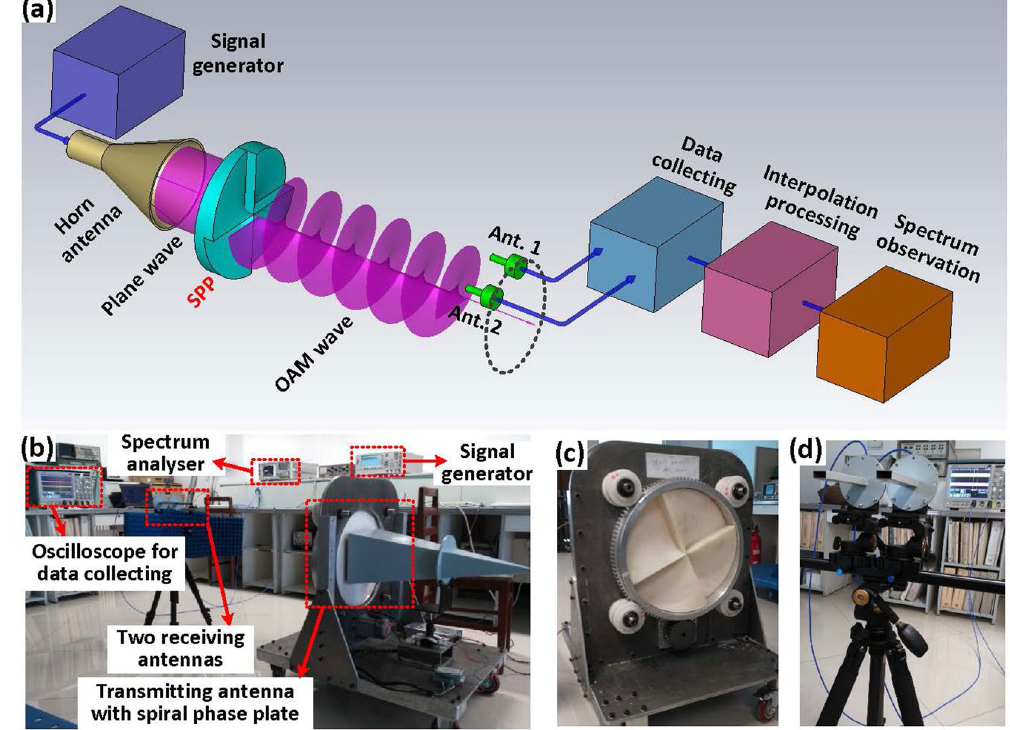
Figure 3. Structure of the experimental system. ( a ) Transceiver structure for detecting the OAM mode using the VRA method. An EM beam is generated by a horn antenna and then passes through the SPP, which produces an OAM wave with mode number l . At the receiving side, the OAM wave is received by two antennas, which are deployed transversely across the doughnut-shaped beam, and then digitally sampled. The sampled data are input to a computer where the interpolation is performed using MATLAB. Afterwards, the interpolated data are output to a spectrum analyser (Agilent E4446A) for observation. ( b ) OAM mode detection experiment conducted in the laboratory. ( c ) Transmitting antenna fabricated by placing the SPP in front of a horn antenna. ( d ) Waveguide antennas used to receive the